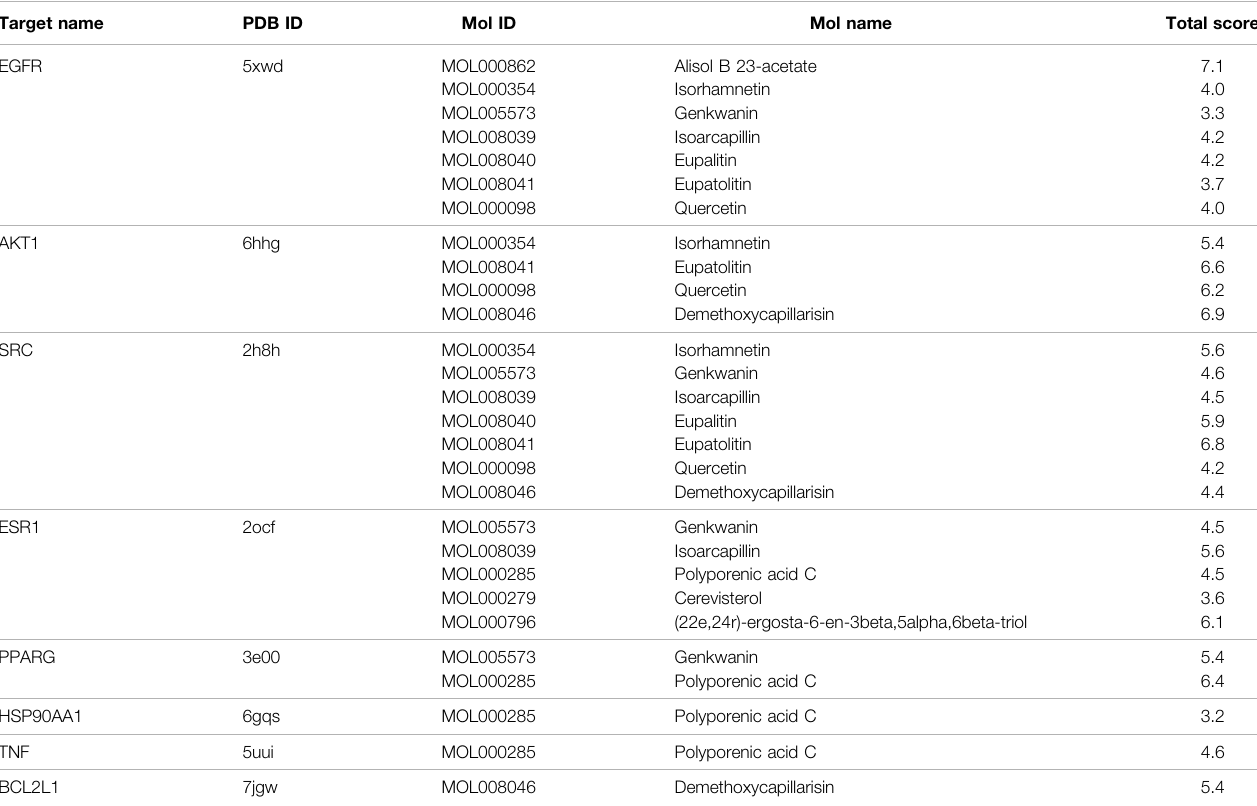
TABLE 3 | Molecular docking of active components with their related targets. Target